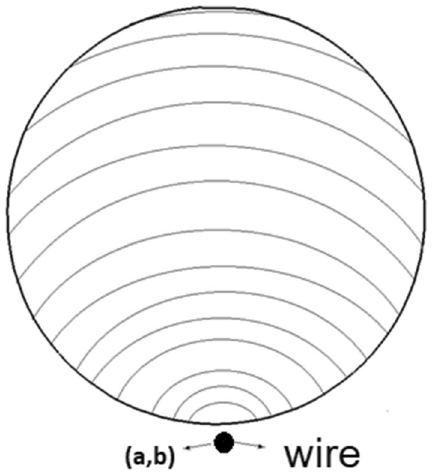
Figure 2. Distribution of non-uniform magnetic field by wire.